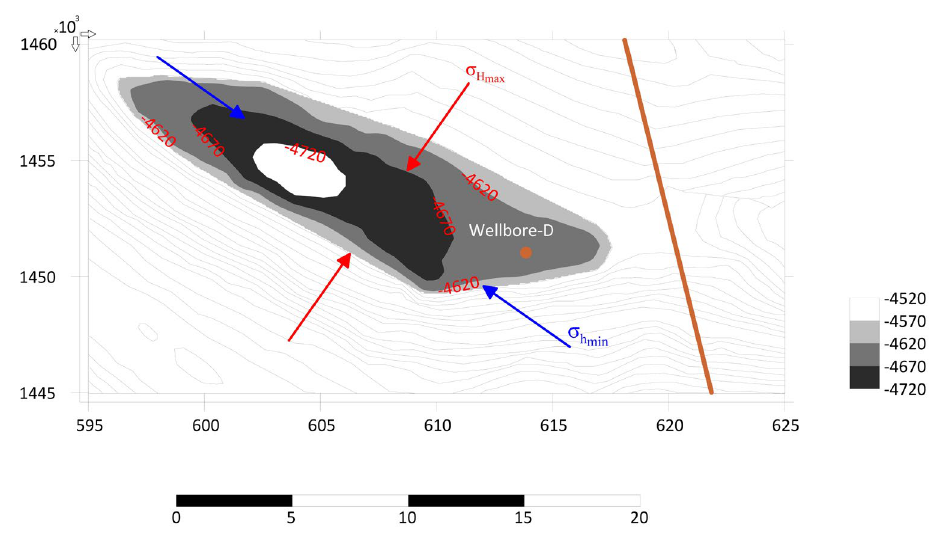
Figure 8. The direction of maximum and minimum horizontal stresses, according to the reverse fault’s configuration in the Azar oilfield. Depths are in meter.